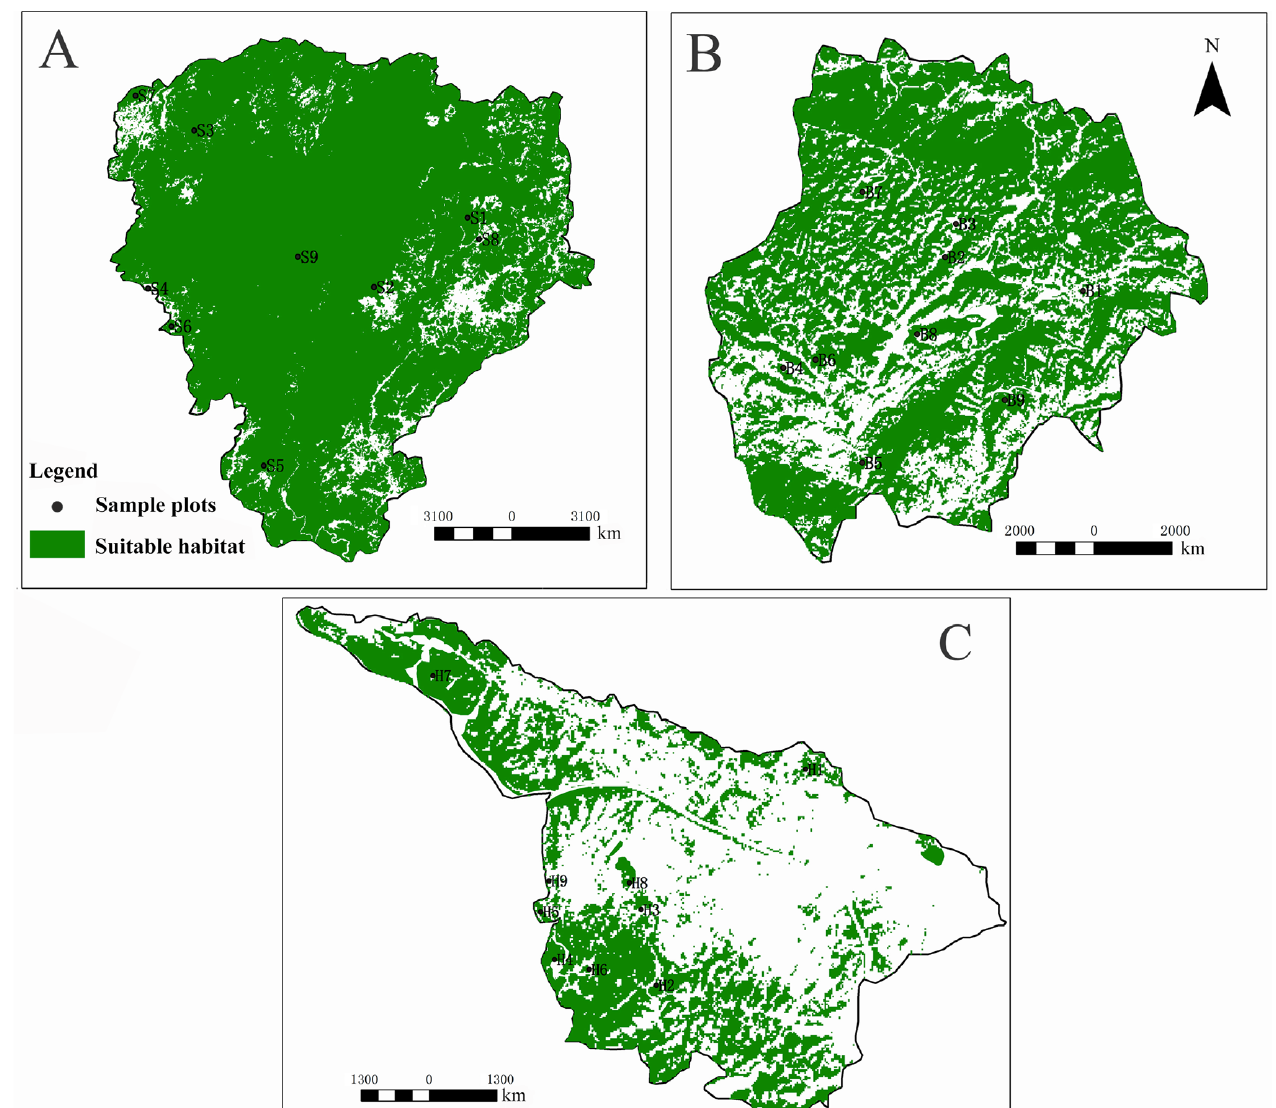
Figure 1. Spatial distribution of habitat of Erythroneurine leafhoppers in study areas. (( A ): Shibing; ( B ): Bijie; ( C ): Huajiang).